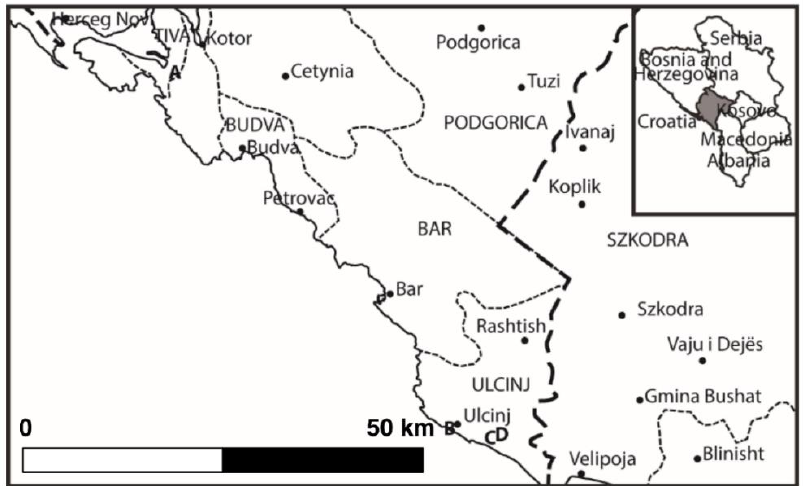
Figure 1. Location of Ulva pilifera sampling sites in Montenegro: A , the River Ulcinj 2 km SE from Durasevici; B , NW of the Ulcinj City, on the Adriatic Coast; C , the ditch near Ulcinjska Solana; D , the Milet Canal in Donji Štoj near Ulcinjska Solana.